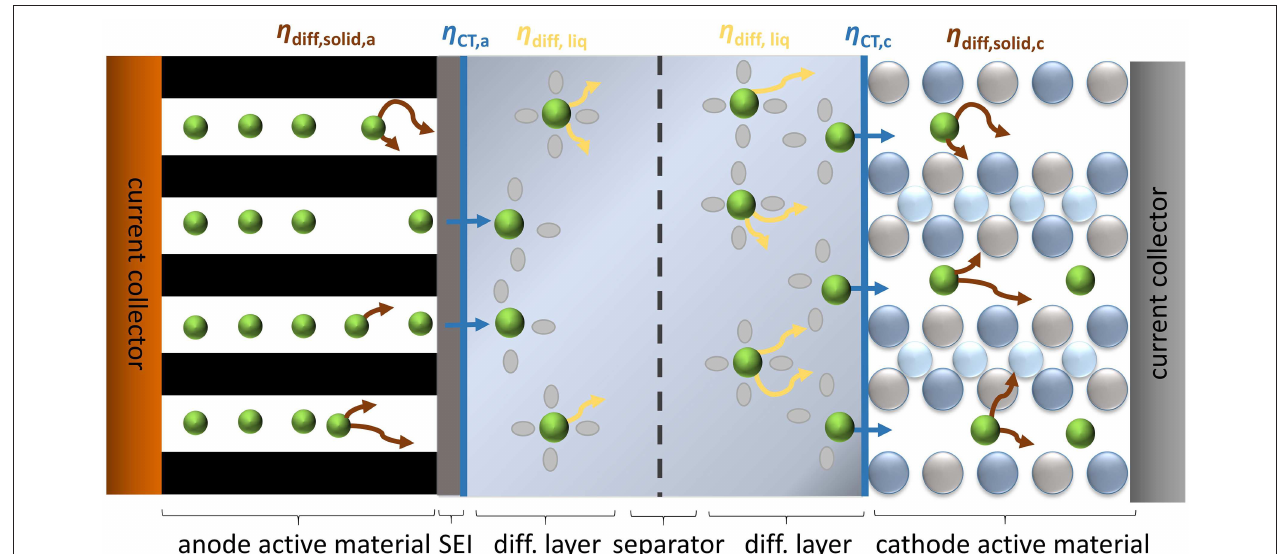
FIGURE 1 | Schematic illustration of the major overpotentials in a lithium-ion battery causing nonlinear distortion of current and